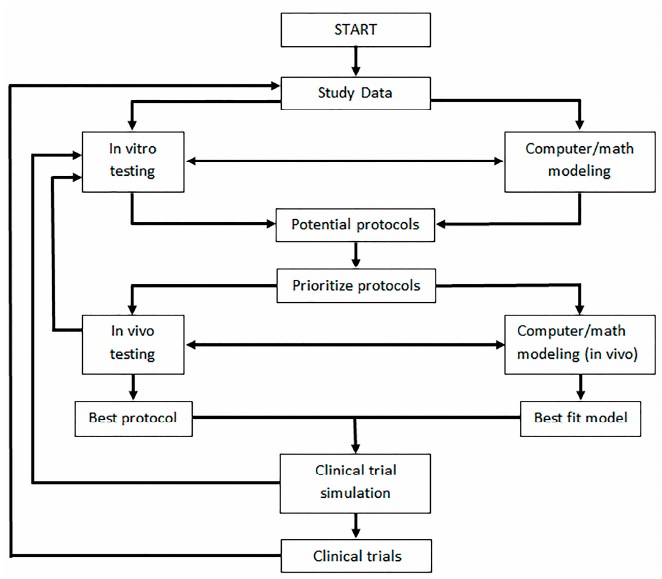
Figure 6. A workflow between experimental and computational data describing an iterative process among in vitro, in vivo, in silico, and clinical models, adapted from [218].